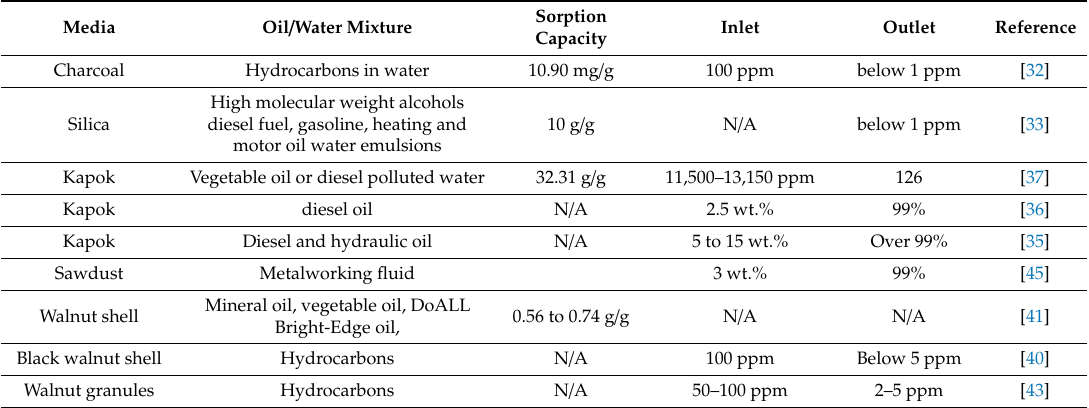
Table 2. Studies devoted to sorption materials based on natural